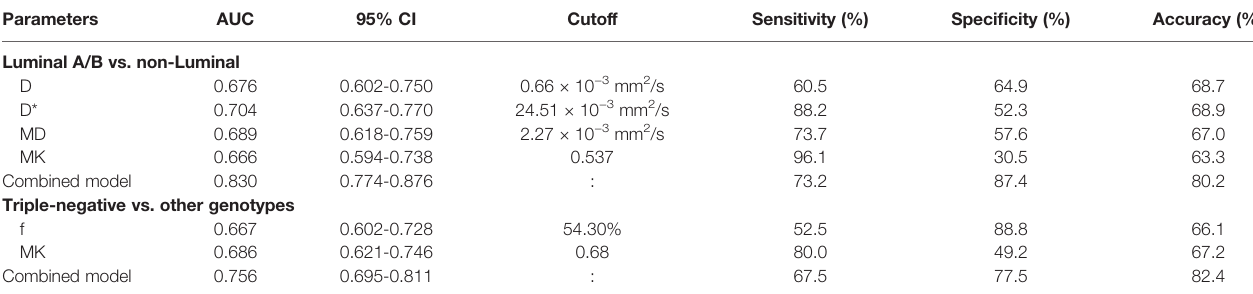
IVIM, intravoxel incoherent motion; DKI, diffusion kurtosis imaging; AUC, area under the